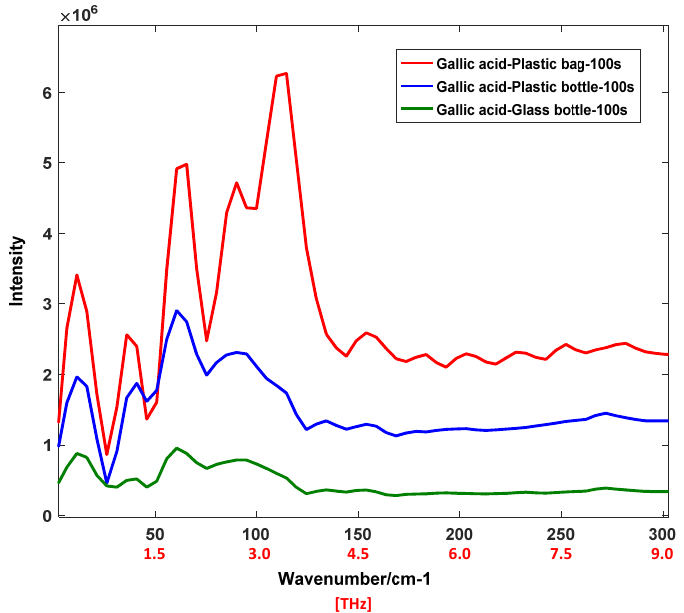
Figure 7. Spectra of gallic acid in different containers with a laser power of 50 mW and integration time of 100 s.